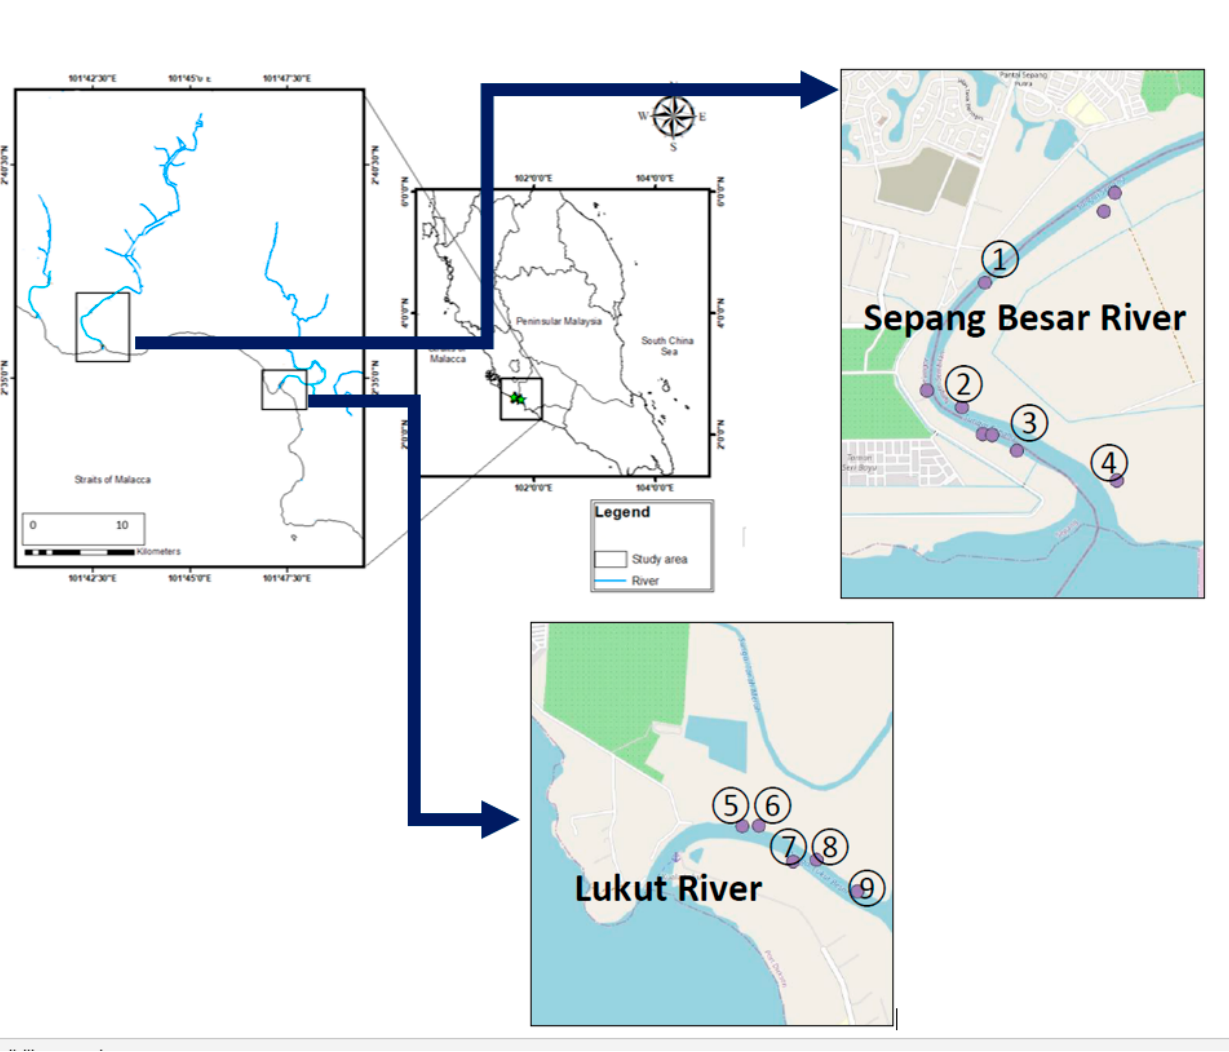
Figure 1. Sampling sites in the Sepang Besar River (1–4), and Lukut River (5–9) from the present study.